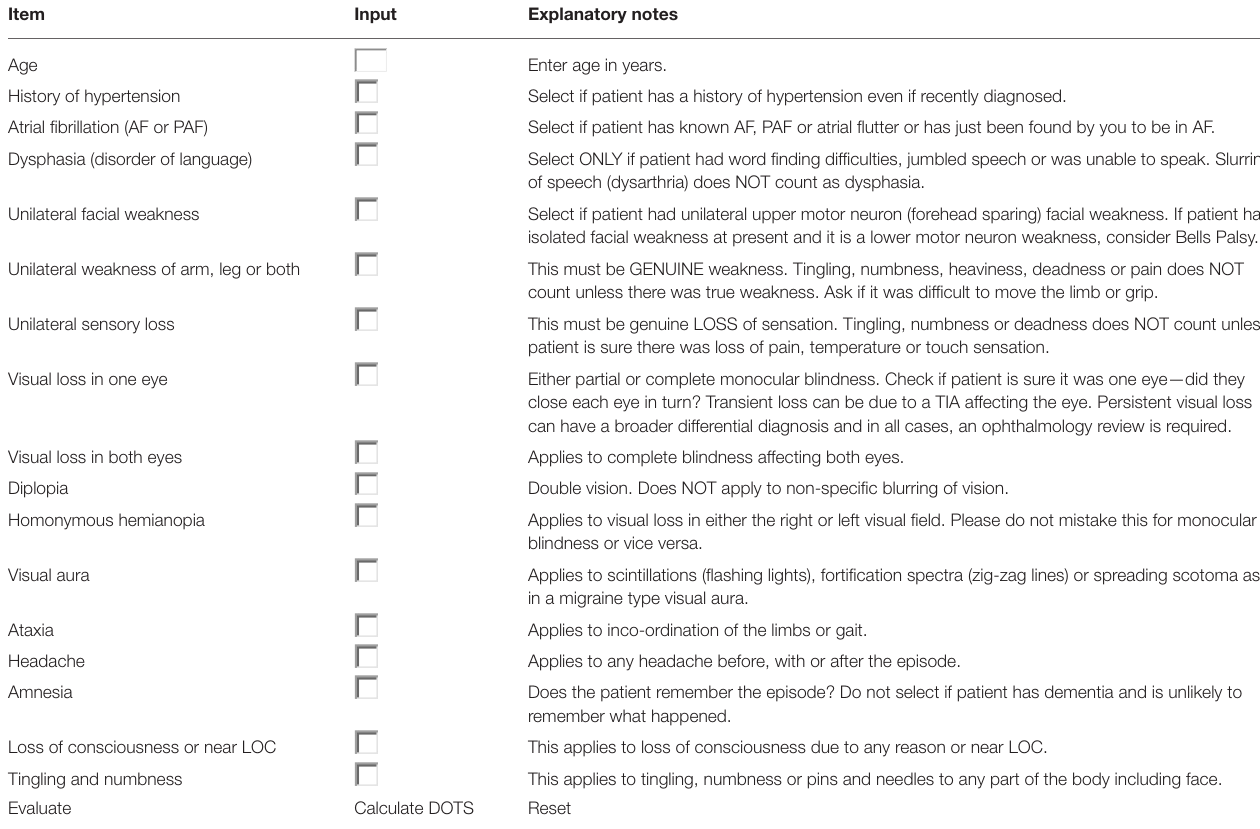
TABLE 2 | The diagnosis of transient ischemic attack (DOT) score (17).